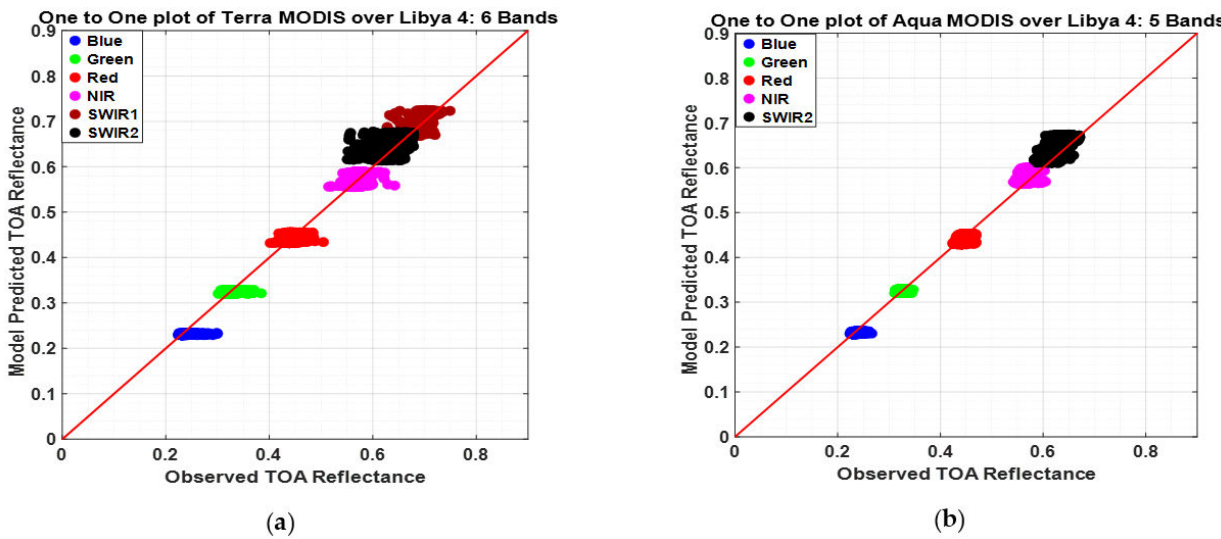
Figure 15. Comparison of the hyperspectral APICS model predicted TOA reflectance and the corresponding observed ( a ) Terra MODIS bands; ( b ) Aqua MODIS bands. Red solid is the reference